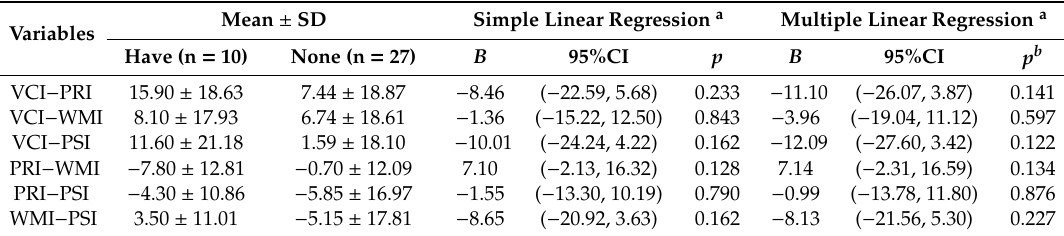
Table 9. The regression analysis between subtest-level discrepancy and distance stereoacuity in the exotropia